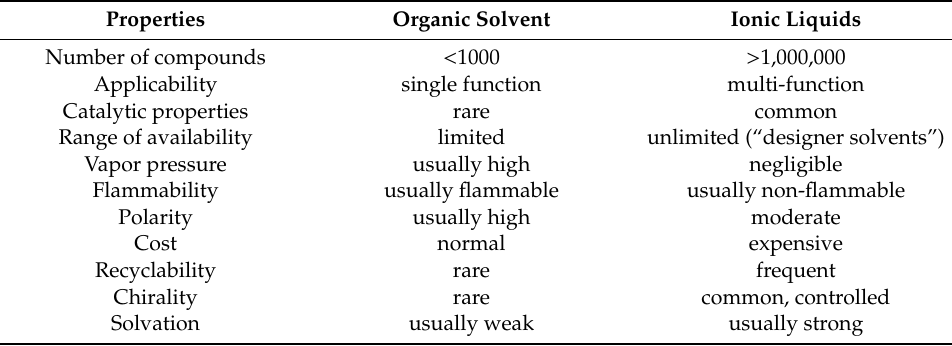
Table 1. A comparison of some properties of organic solvents and ionic liquids [19]. Properties Organic